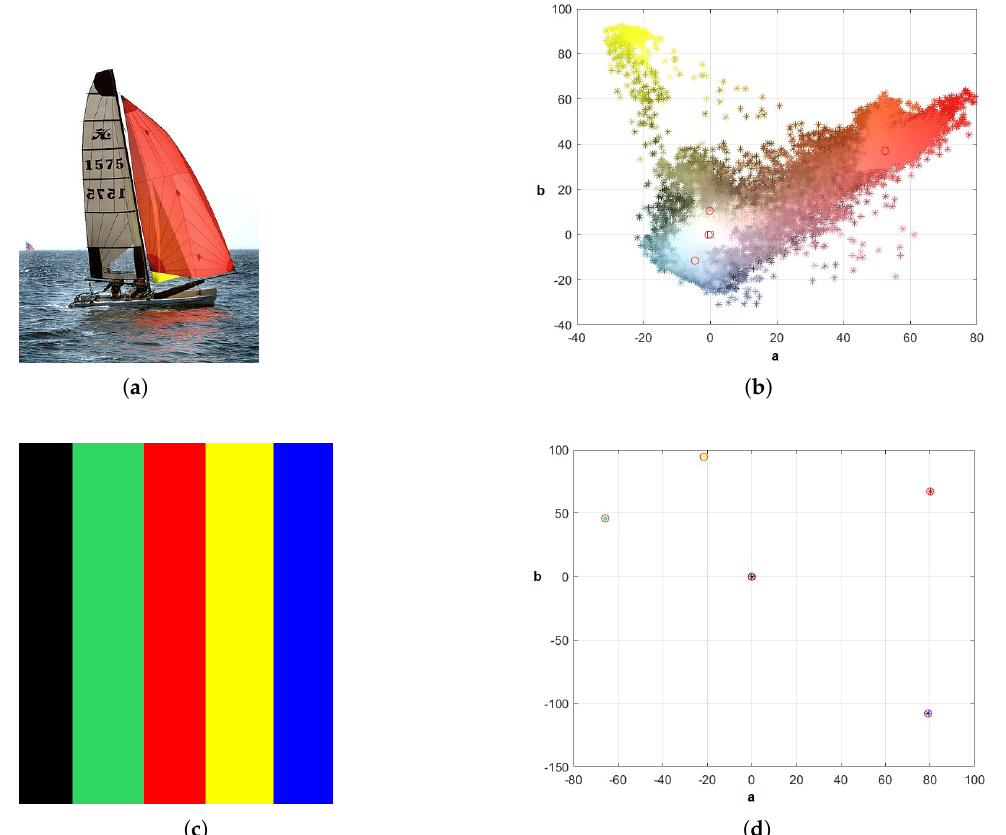
Figure 4. Chromatic map AB for two color images. ( a ) Color image 1. ( b ) Chromatic map AB of image 1. ( c ) Color image 2. ( d ) Chromatic map AB of image 2.